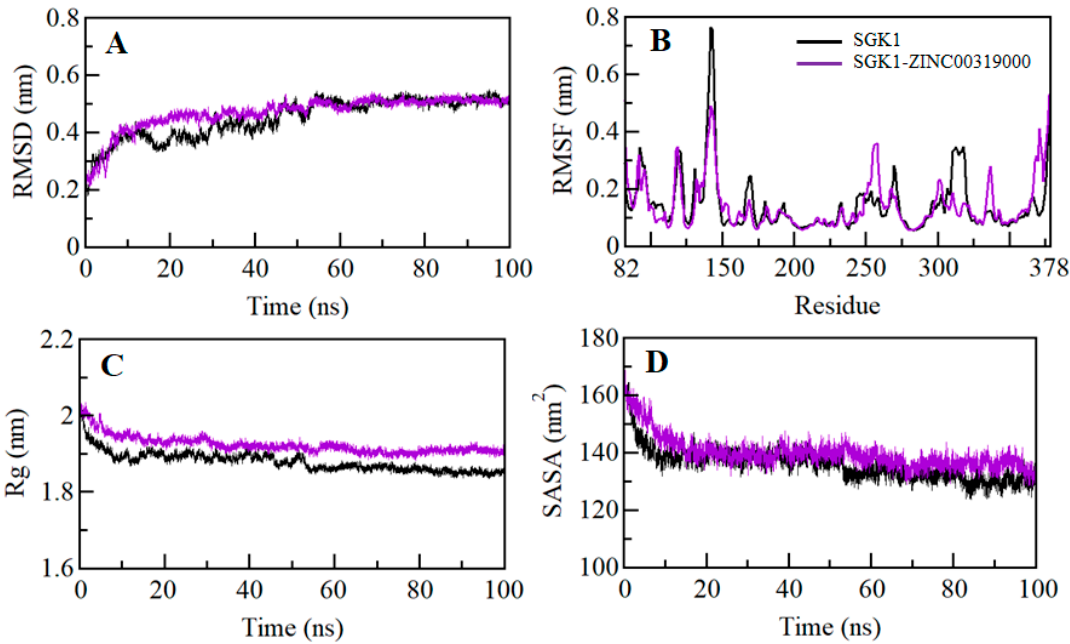
Figure 5. Structural dynamics of SGK1 as a function of time. ( A ) Root-mean-square deviation (RMSD) plot of SGK1 before and after binding of ZINC00319000. ( B ) Residual fluctuations plot of SGK1 before and after ZINC00319000 binding. ( C ) Time evolution of the radius of gyration. ( D ) SASA plot of SGK1 as a function of time. The values were obtained from the 100 ns molecular dynamic (MD) simulation time scale. Black and violet represent values obtained for SGK1 apo and SGK1-ZINC00319000 complex, respectively.